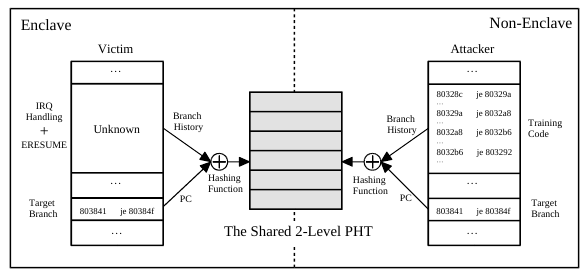
Figure 7: Implementation in an SGX-based environment. The same branch history and the same PC lead to the same 2-level PHT